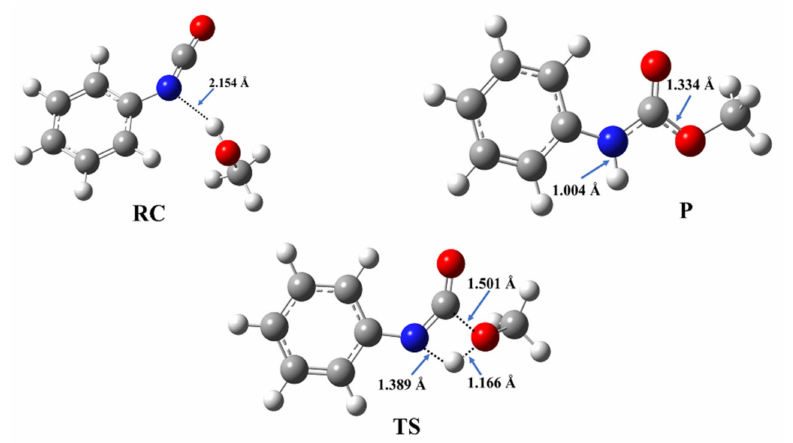
Figure 2. Three-dimensional structures of the reactant complex (RC), transition state (TS), and product (P) in the reaction of methanol and phenyl isocyanate, which are used as a model of catalyst-free urethane formation. The structures have been optimized at the BHandHLYP/6-31G(d) level of theory in acetonitrile at 298.15 K and 1 atm.